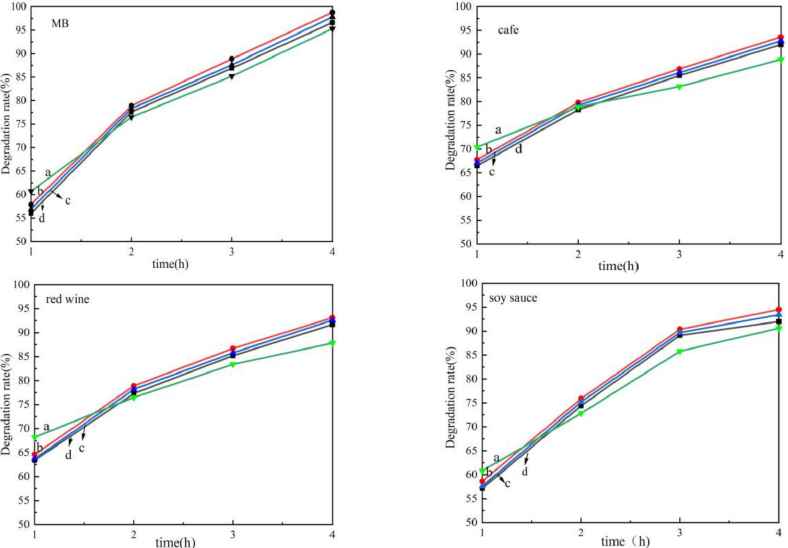
Figure 8. Degradation rates of ZnO/cotton ( a ), OA-ZnO/cotton ( b ), TA-ZnO/cotton ( c ), and SA- ZnO/cotton ( d ) to MB, coffee, red wine, and soy sauce under different irradiation